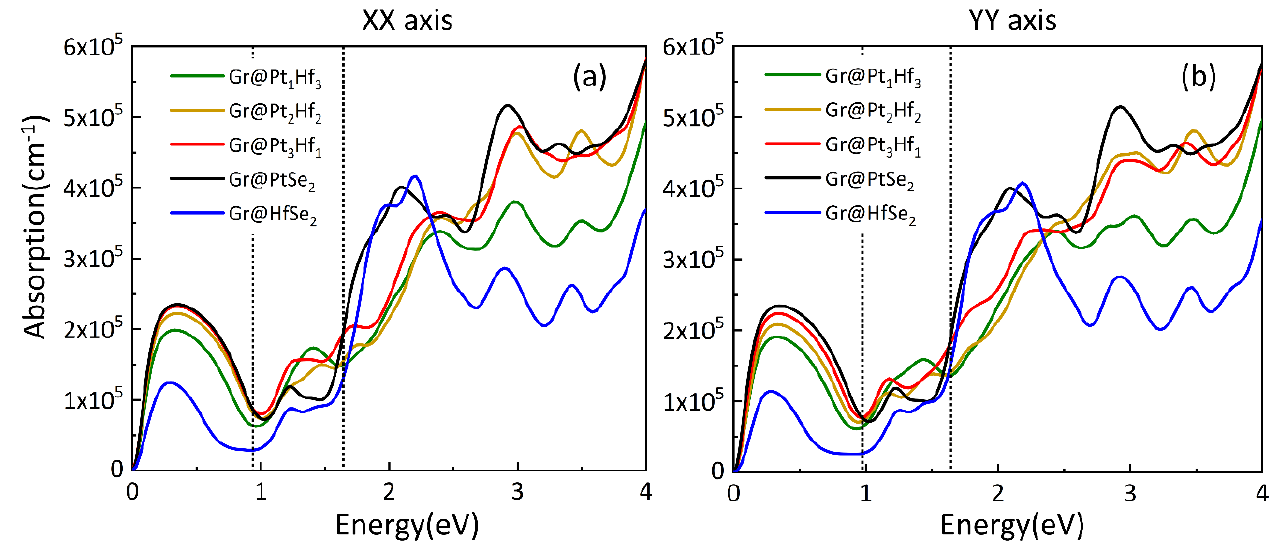
Figure 7. The calculated absorption spectra for the Gr@PtSe 2 , Gr@Pt n Hf 4 − n , and Gr@HfSe 2 heterostructures are shown in ( a , b ) for the XX and YY directions, respectively, where XX represents the long side of the rectangular structure and YY represents the short side of the rectangular structure.